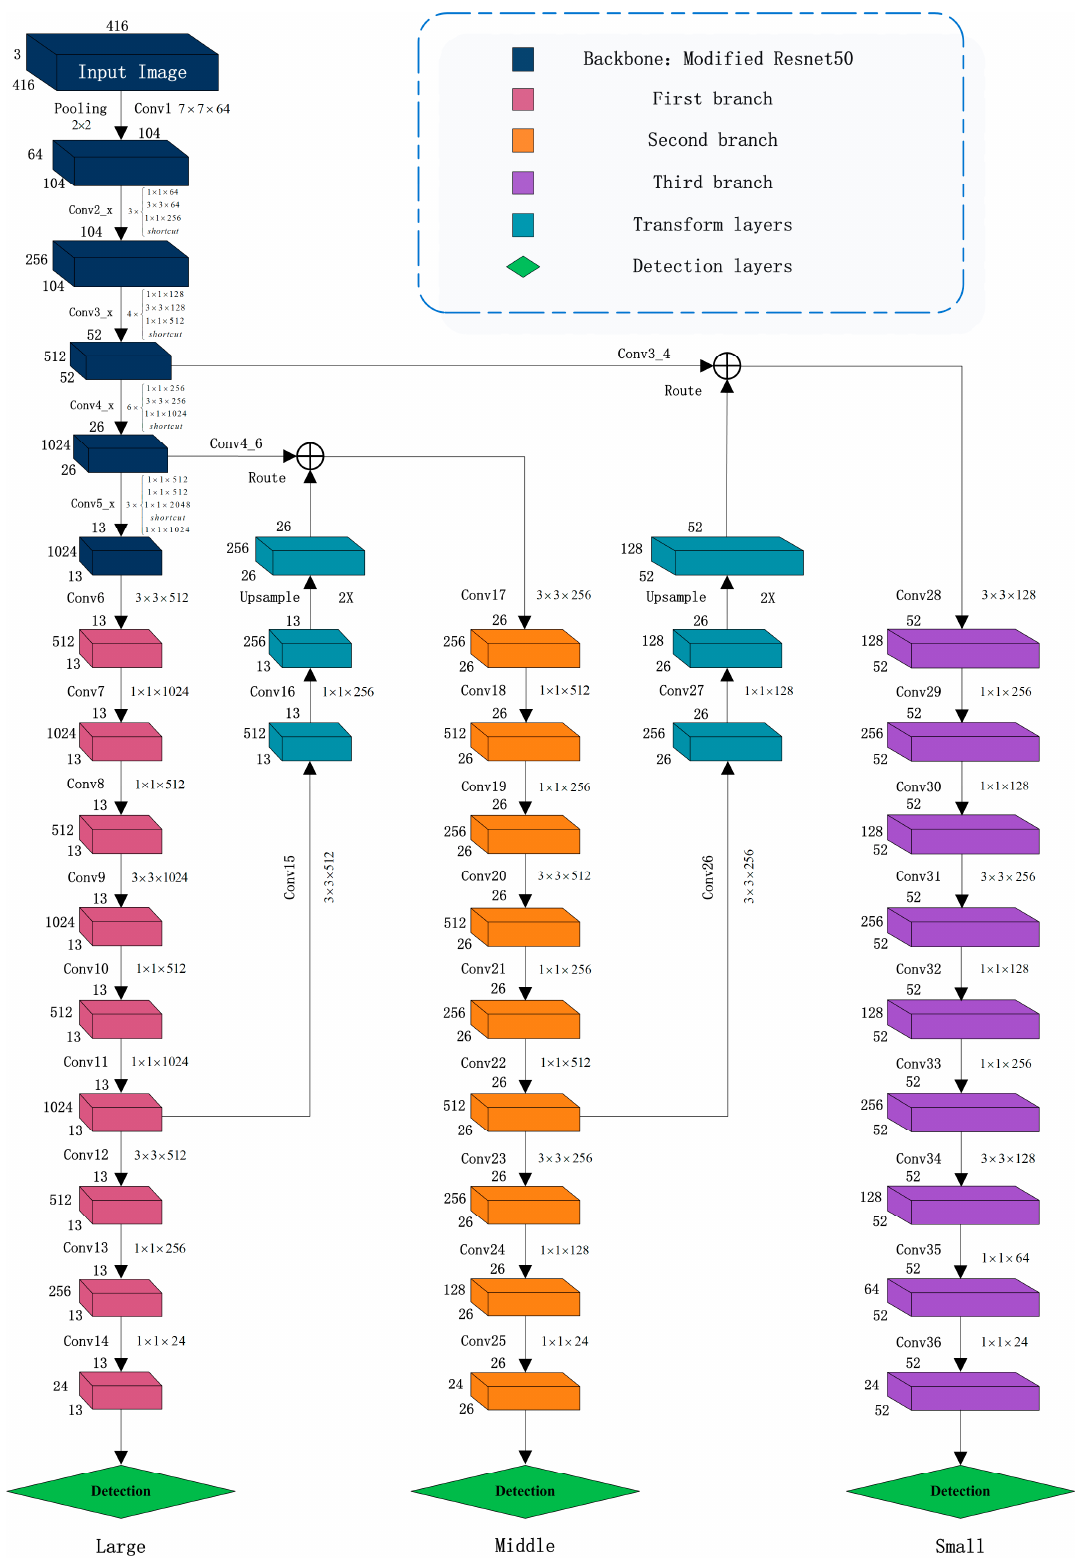
Figure 2. The architecture of the proposed